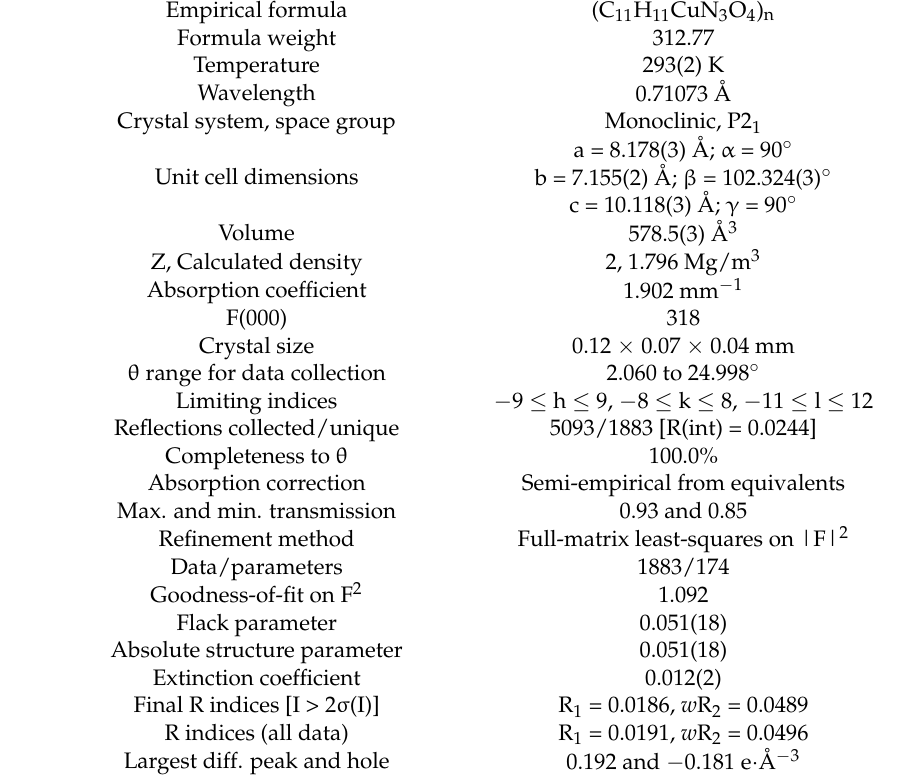
Table 1. Crystal data and structure refinement parameters for title